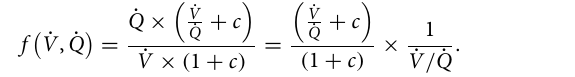
The full deduction of these relationships has previously been described 10 . . . V O V O Blood flow calculations were performed for measurements of . . . 2 derived from blood content ( 2 ), gaseous V CO V / ˙ Q of 1 ( V CO measurements of . . 2 , normalized at the lung for a 2,GasNorm ) in order to assess the efficacy of V CO V CO the normalization procedure, gaseous measurements of . . 2 , not normalized ( 2,Gas ) in order to simulate V CO V CO clinical conditions and 2 measurement derived from blood content ( 2,Blood ). . . V CO V / ˙ Q of 1. Blood flow determines the amount of CO Normalization of towards a 2 2 transported towards the membrane lung, while ventilation determines the amount of CO 2 eliminated over the respective . . V / ˙ Q differs from 1, V CO 11 and thus does membrane lung. When 2 is predominantly determined by ventilation not correlate well with blood flow. This results in different venoarterial content differences across the ECMO and lung, which will introduce an error into Eqs. (3) and (4). As we aim to calculate blood flow through the lungs, we . . V CO V / ˙ Q of 1 10 : correct 2 values on the ECMO towards a